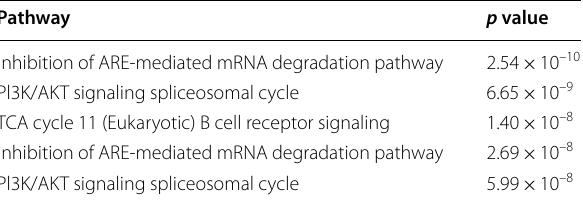
Table 2 Ingenuity Pathway Analysis uncovered the top five canonical pathways